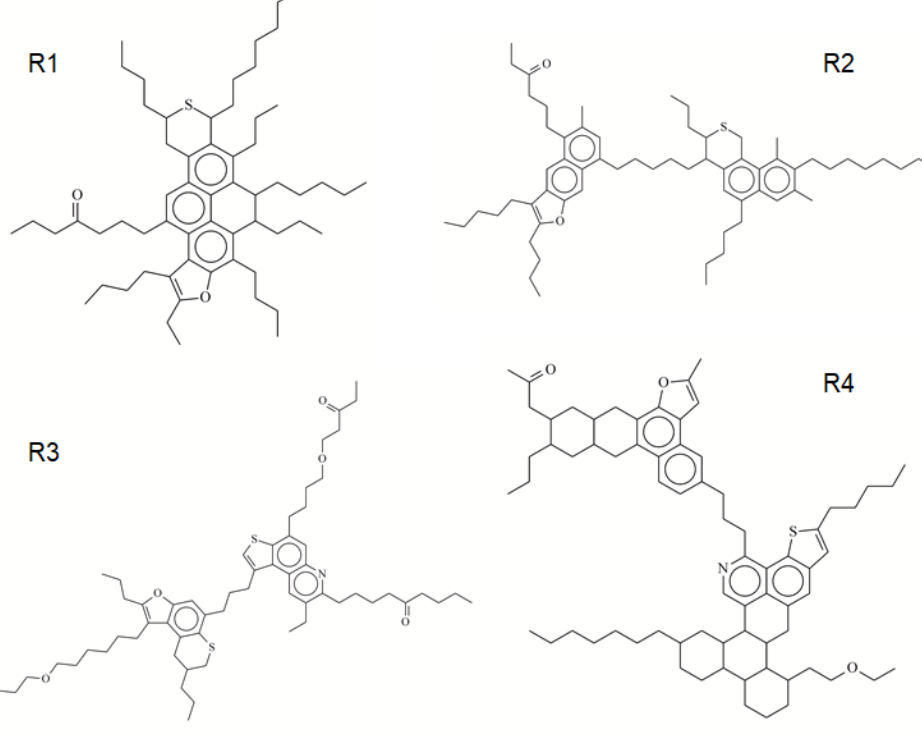
Figure 6. Spatial structures of resin fractions of initial oil.